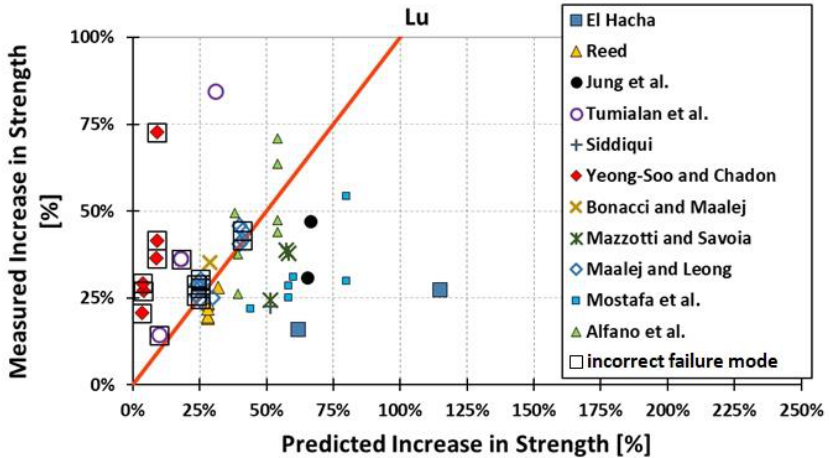
Figure 13. Measured increase in flexural strength versus Teng et al. model prediction.